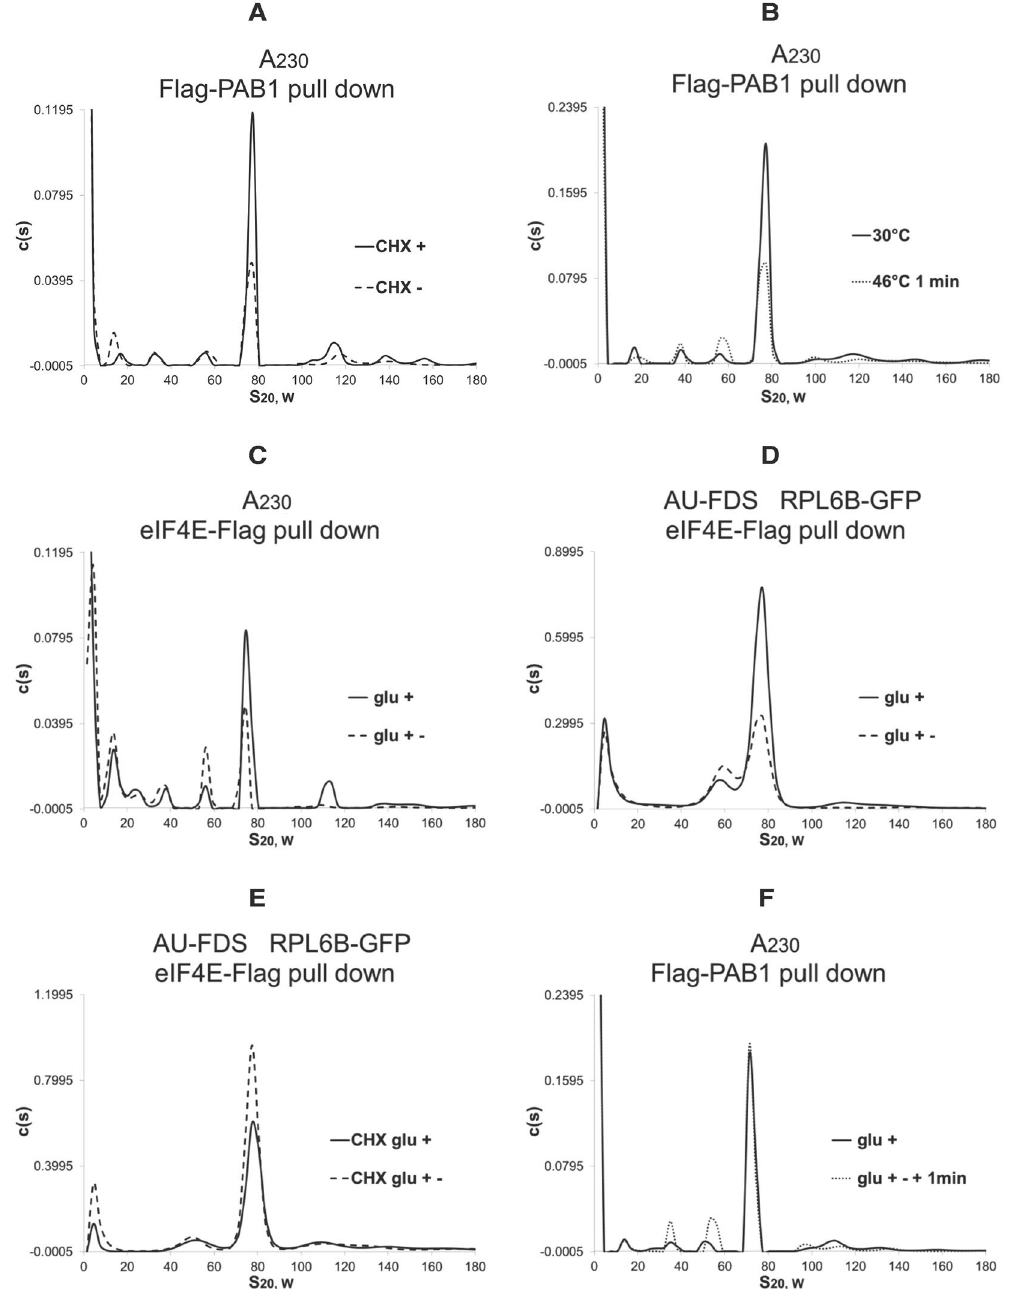
Figure 3. AUC analyses following Flag-PAB1 and eIF4E-Flag purifications. Experiments were conducted as described in Fig. 1. Cycloheximide experiments were conducted as described in the Materials and Methods. For panel A, cycloheximide was either added to cells prior to lysis (CHX + ) or not (CHX − ). For panel D, cycloheximide was added after the indicated treatment as normal as described in the Materials and Methods, whereas in panel 4E cycloheximide was added for 10 min prior to lysis (CHX glu + ) or for 10 min before the shift to glucose depleted medium that was then followed by cell lysis (CHX glu +